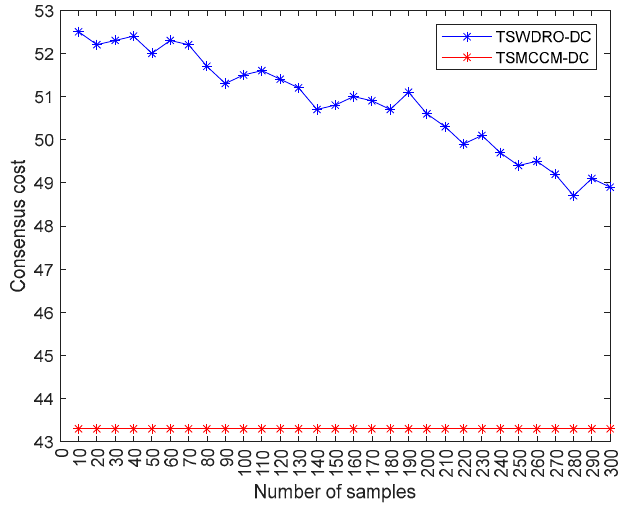
Figure 1. Comparison of the TSWDRO-DC and TSMCCM-DC results.